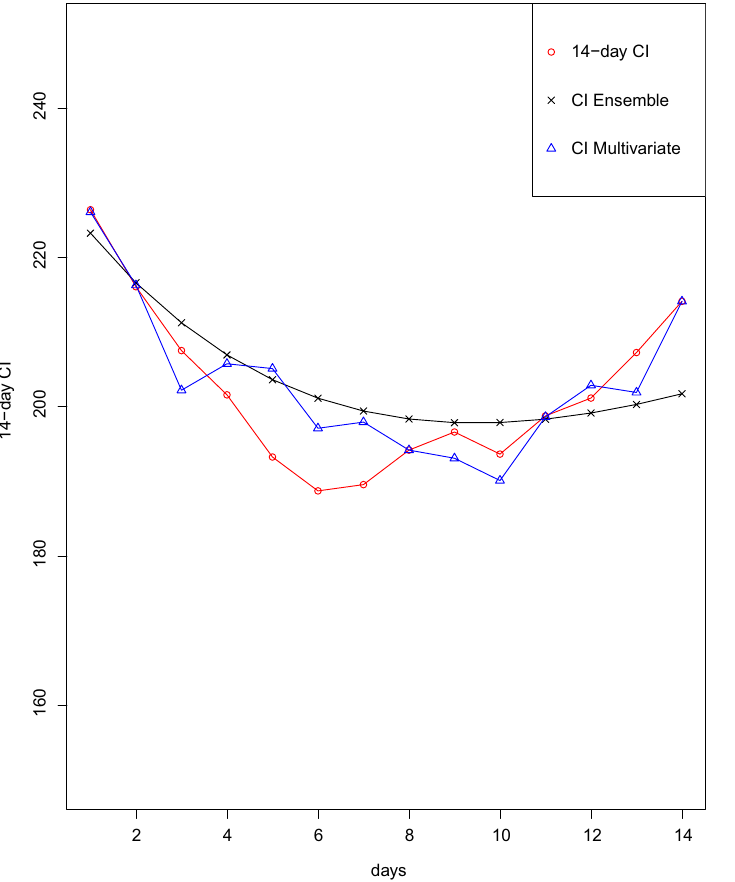
Figure 6. 14-day CI accuracy prediction for different estimated